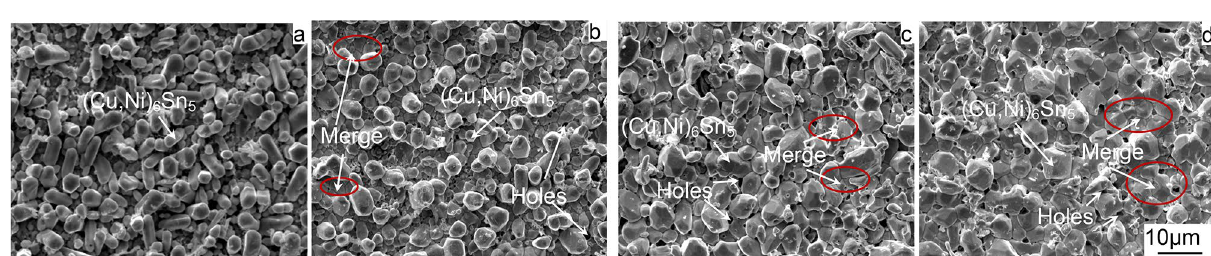
Figure 6. The SEM images of IMC of Sn2.5Ag0.7Cu0.1RExNi/Cu solder joints ( a 1 – d 1 ) 0Ni, ( a 2 – d 2 ) 0.05Ni, ( a